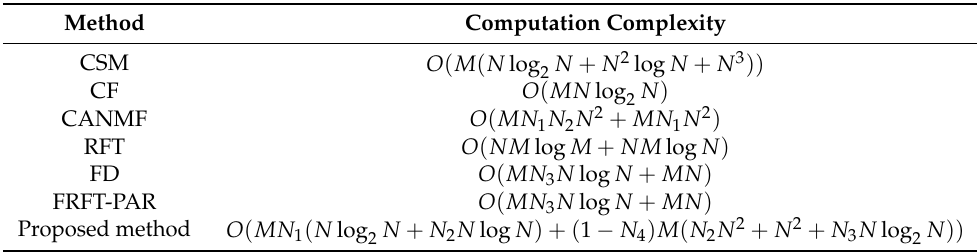
Table 5. Computational